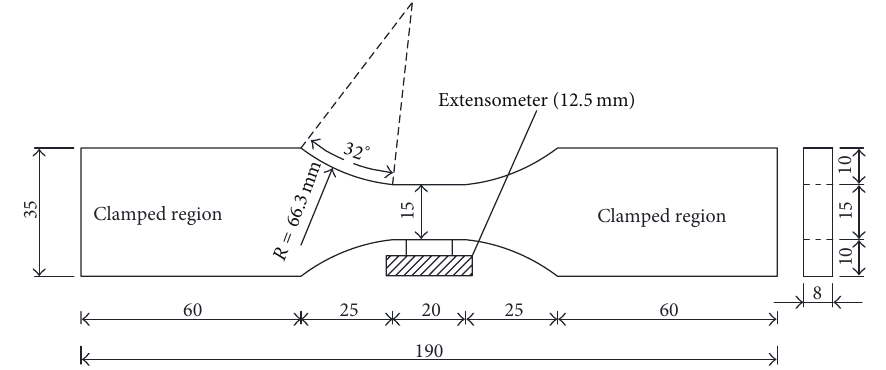
Figure 1: Dimension of the specimen.